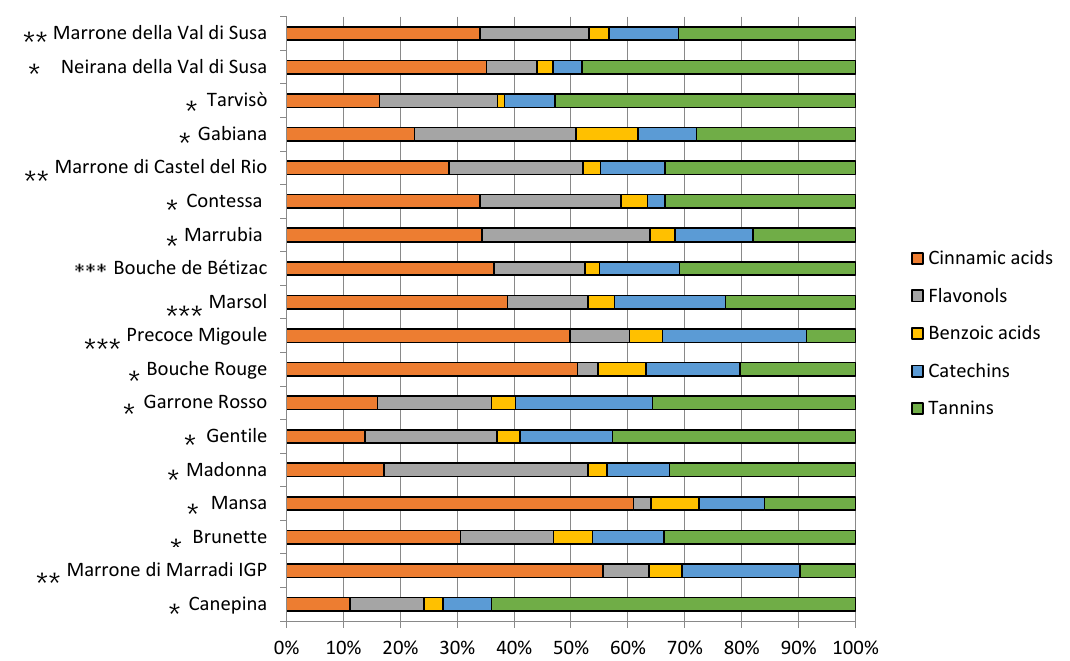
Figure 7. Polyphenol profile of the analysed chestnut cultivars. * Sweet chestnut (SC). ** Marrone-type chestnut (MT). *** Euro-Japanese hybrid (EH).